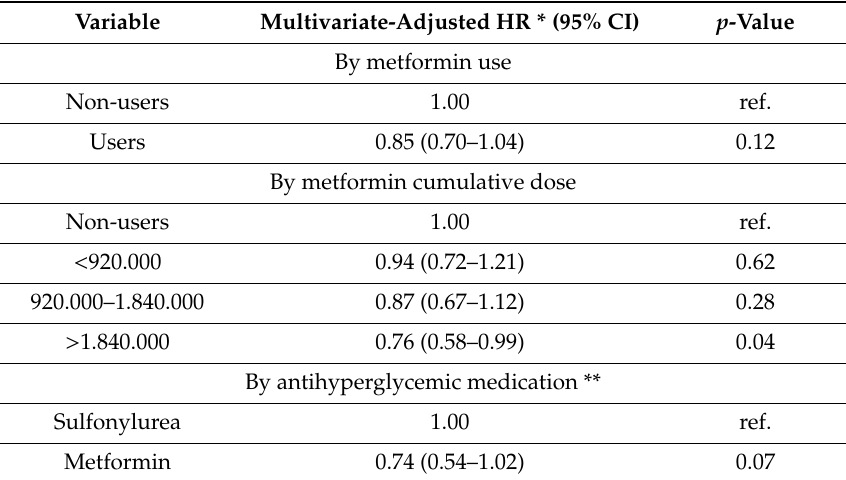
Figure 2. Kaplan–Meier survival curve comparing overall survival between diabetic sulfonylurea users and metformin users (monotherapy groups). Table 3. HR and 95% CI of the association of metformin use, and overall mortality in diabetic pancreatic cancer patients.